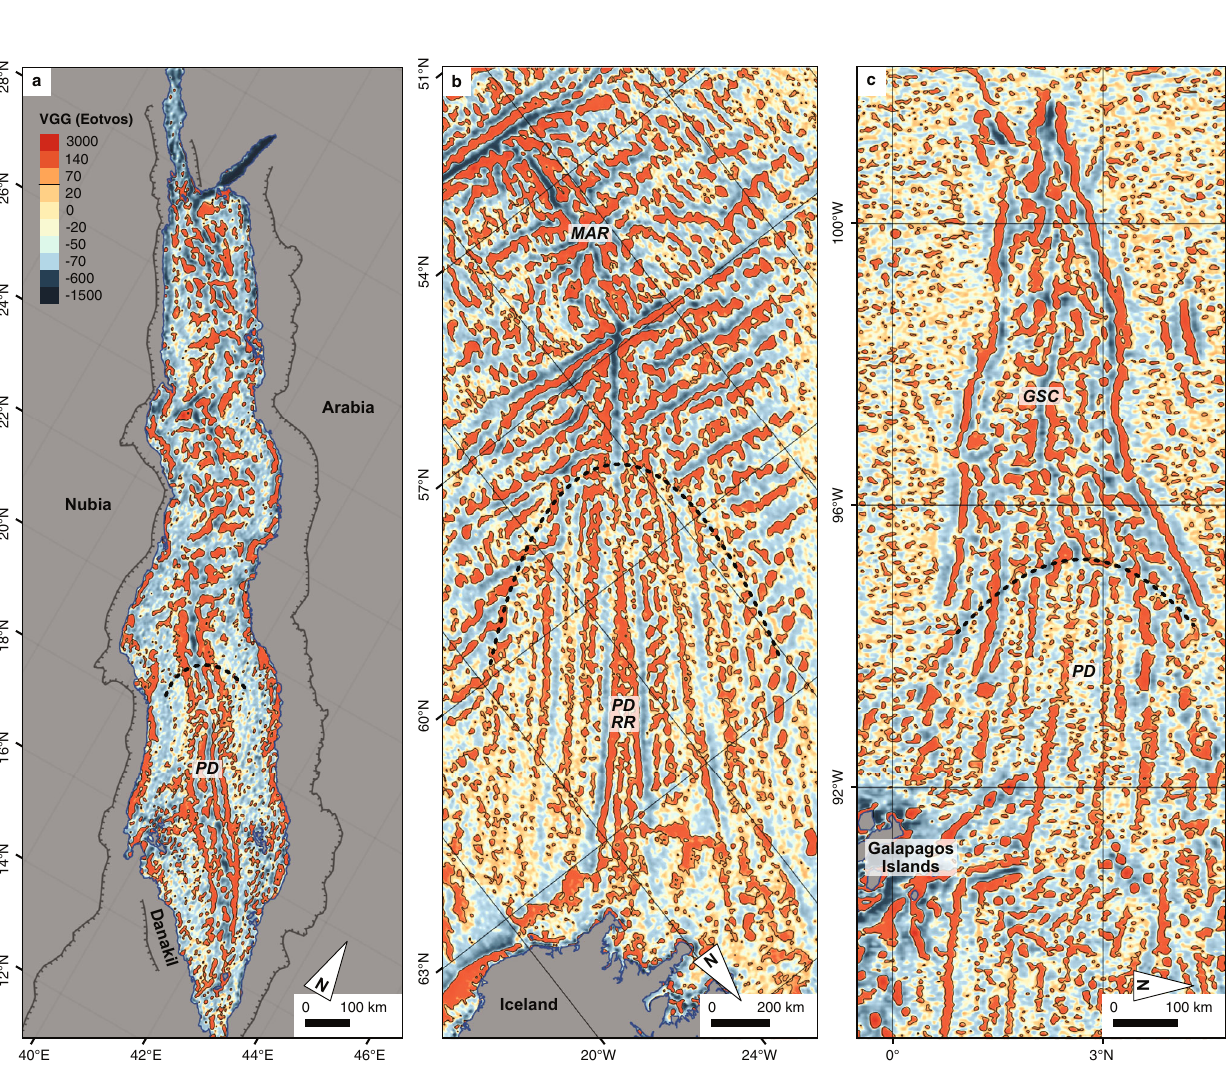
Fig. 3 Off-axis segmentation trails in slow-spreading ocean rifts revealed by vertical gravity gradient data. a In the widely salt- and sediment-covered Red Sea Basin, the vertical gravity gradient data reveal axis-perpendicular segmentation trails north of 20°N. The identi fi ed trails (dashed white lines) are numbered from north to south by roman numbers. The rose diagram shows the average direction of rift-axis segments (white) vs. the average direction of segmentation trails (orange). RS-DS-TF = Red Sea – Dead Sea transform fault, NRSR = northern Red Sea Rift, ZFZ = Zabargad fracture zone, CRSR = central Red Sea Rift. b The non-sediment buried Southwest Indian Ridge (SWIR) within the Central Indian Ocean domain (CIR) and the Southeast Indian Ocean domain (CEIR); FZ = fracture zone. c Aegir Ridge (AR), buried under <1 km thick sediment cover 18 (SKR = Southern Kolbeinsey Ridge, MR = Mohns Ridge). d South China Sea (SCS) spreading centre covered by 1 – 2 km sediment 19 (MBB = Maccles fi eld Bank Block, RBB = Reed Bank Block, MT = Manila Trench). e The Labrador Sea Spreading Centre (LSSC) buried under 2 km sediments 20 (UFZ = Ungava Fault Zone). The quantile colour-key is the same for all maps, and the segmentation trails are well visible at ≥ 70 E (eotvos), which marks the maximum value of the full-width at half-maximum (FWHM) mean range of the global vertical gravity gradient dataset.